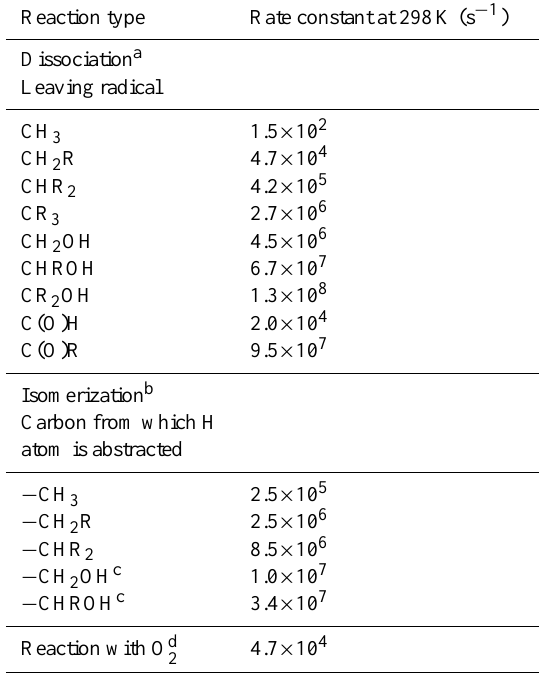
Table 3. Rates of alkoxy radical reactions as presented by Kroll and Seinfeld (2008), based upon recommendations by Atkinson